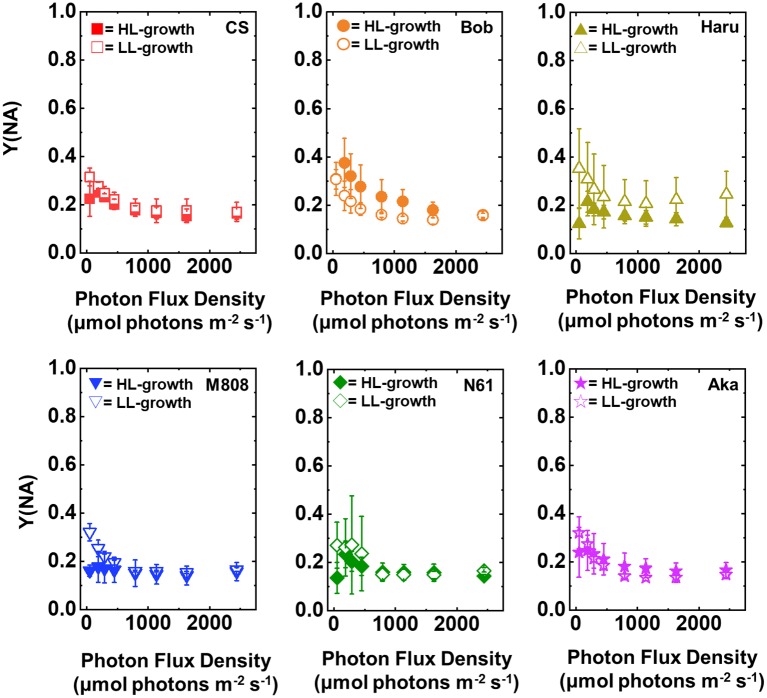
The response of Y(NA) to light intensity in six wheat cultivars grown under LL (open symbol) and HL (closed symbol) conditions. The measurement was conducted under atmospheric conditions (21 kPa O2, 40 Pa CO2) at 25°C. Data were expressed as mean ± SD of three to five independent experiments. Red squares indicate the results of CS, orange circles indicate the results of Bob, dark yellow triangles indicate the results of Haru, blue inverted-triangles indicate the results of M808, green diamonds indicate the results of N61, and purple stars indicate the results of Aka.